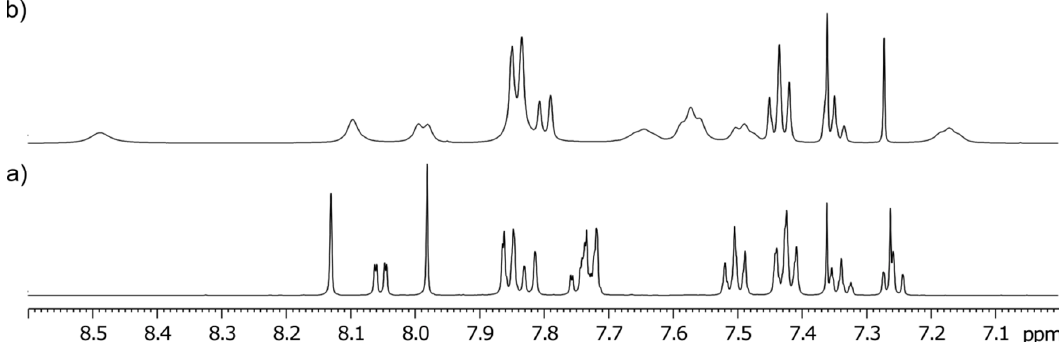
Figure 3. Aromatic region of 1 H NMR spectra of: ( a ) 2b in CDCl 3 , and ( b ) a mixture of 2b (42 mM) and [RuCl( μ -Cl)( η 6 - p -cymene)] 2 (21 mM) in CDCl 3 immediately after dissolution.